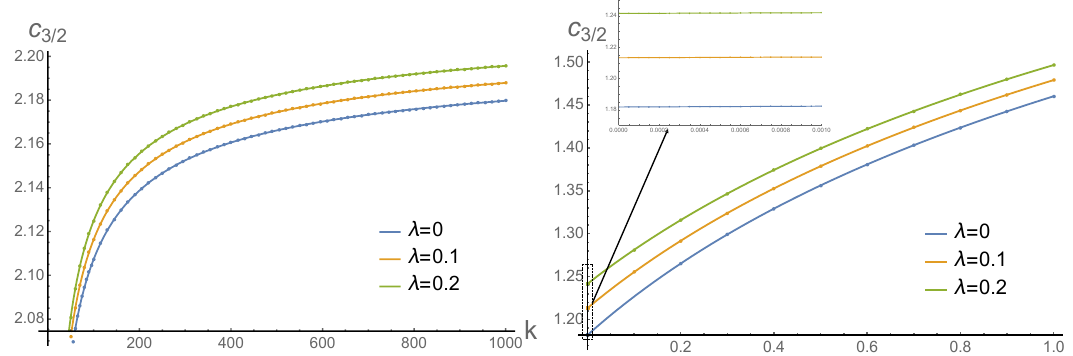
coefficient as a function of k is plotted in the large, middle and small k region Figure 2 . The c 3 / 2 for different λ , with fixed q 2 = 1 . 4 . The dots are the numerical data and lines are the analytical function (3.1), and they have perfect match even though the data run over 7 orders of